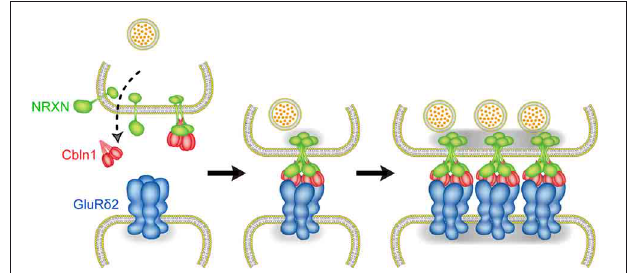
FIGURE 5 | Molecular mechanism of PF-PC synapse formation. Before PF-PC synapse formation, Cbln1 secreted from cerebellar GCs may interact with presynaptic NRXNs. Cbln1-induced NRXN dimerization is not sufficient to trigger presynaptic differentiation. When the contact between the PF terminal and PC spine takes place, GluR δ 2 triggers synapse formation by clustering four NRXNs through triad